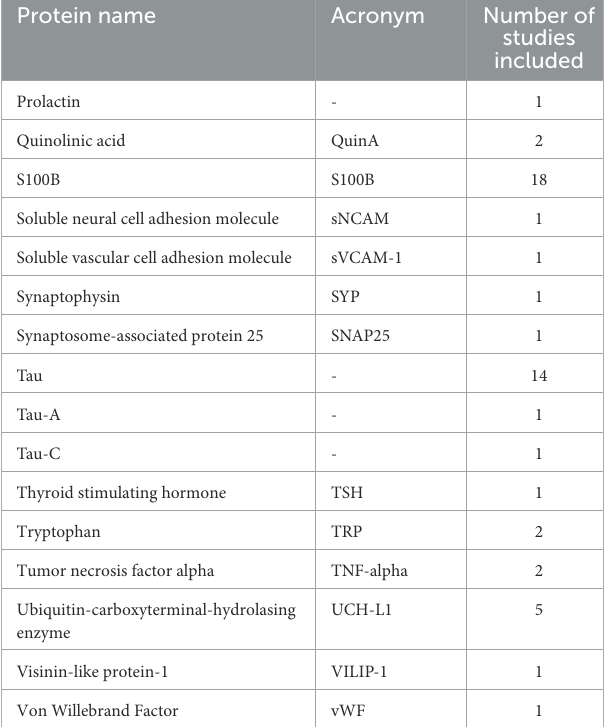
TABLE 1 Blood biomarkers and the number of studies in which they were